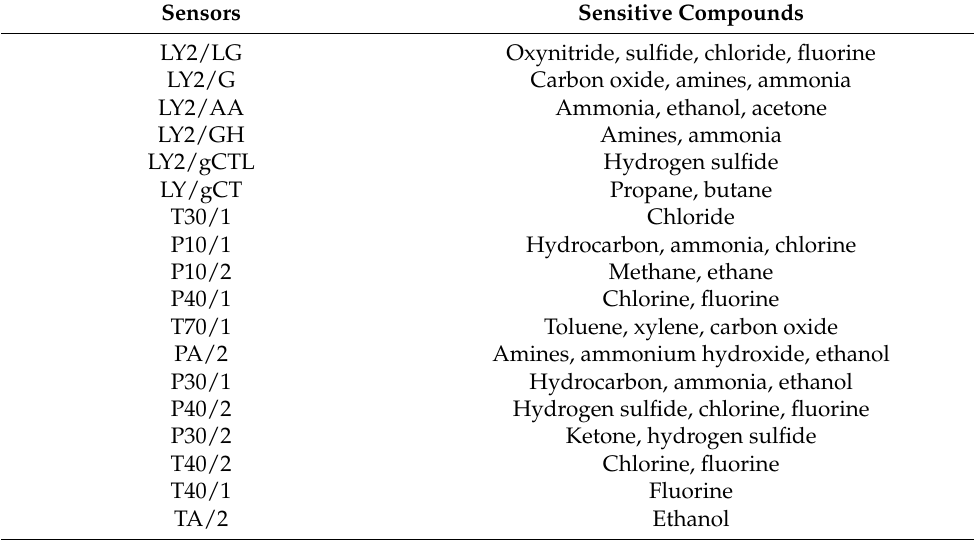
Table 3. Sensors and sensitive compounds of electronic nose.